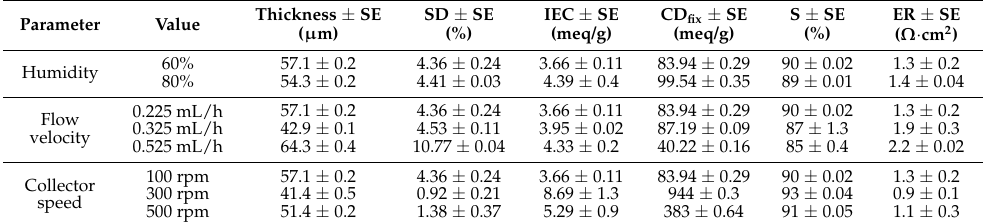
Table 9. Influence of the humidity, flow velocity and collector speed on the AEM properties. Parameter